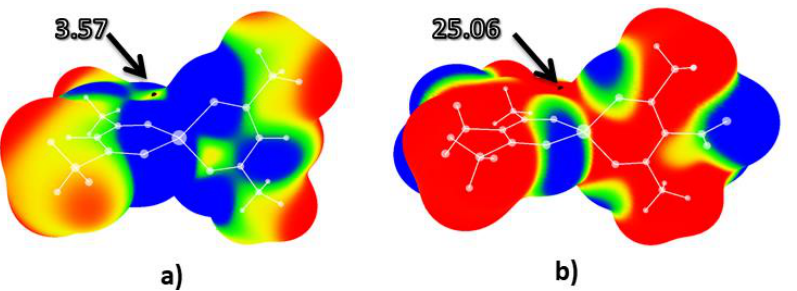
Figure 3. Calculated electrostatic potential maps for: ( a ) bis(acetylacetonato) zinc (II), and ( b ) nitro- bis(acetylacetonato) zinc (II) complexes. Color ranges, in kcal/mol, are: red, greater than 6.28, yellow, from 0.00 to 6.28, green, from − 6.28 to 0.00, and blue, more negative than − 6.28. Black dots represent critical points on the molecular